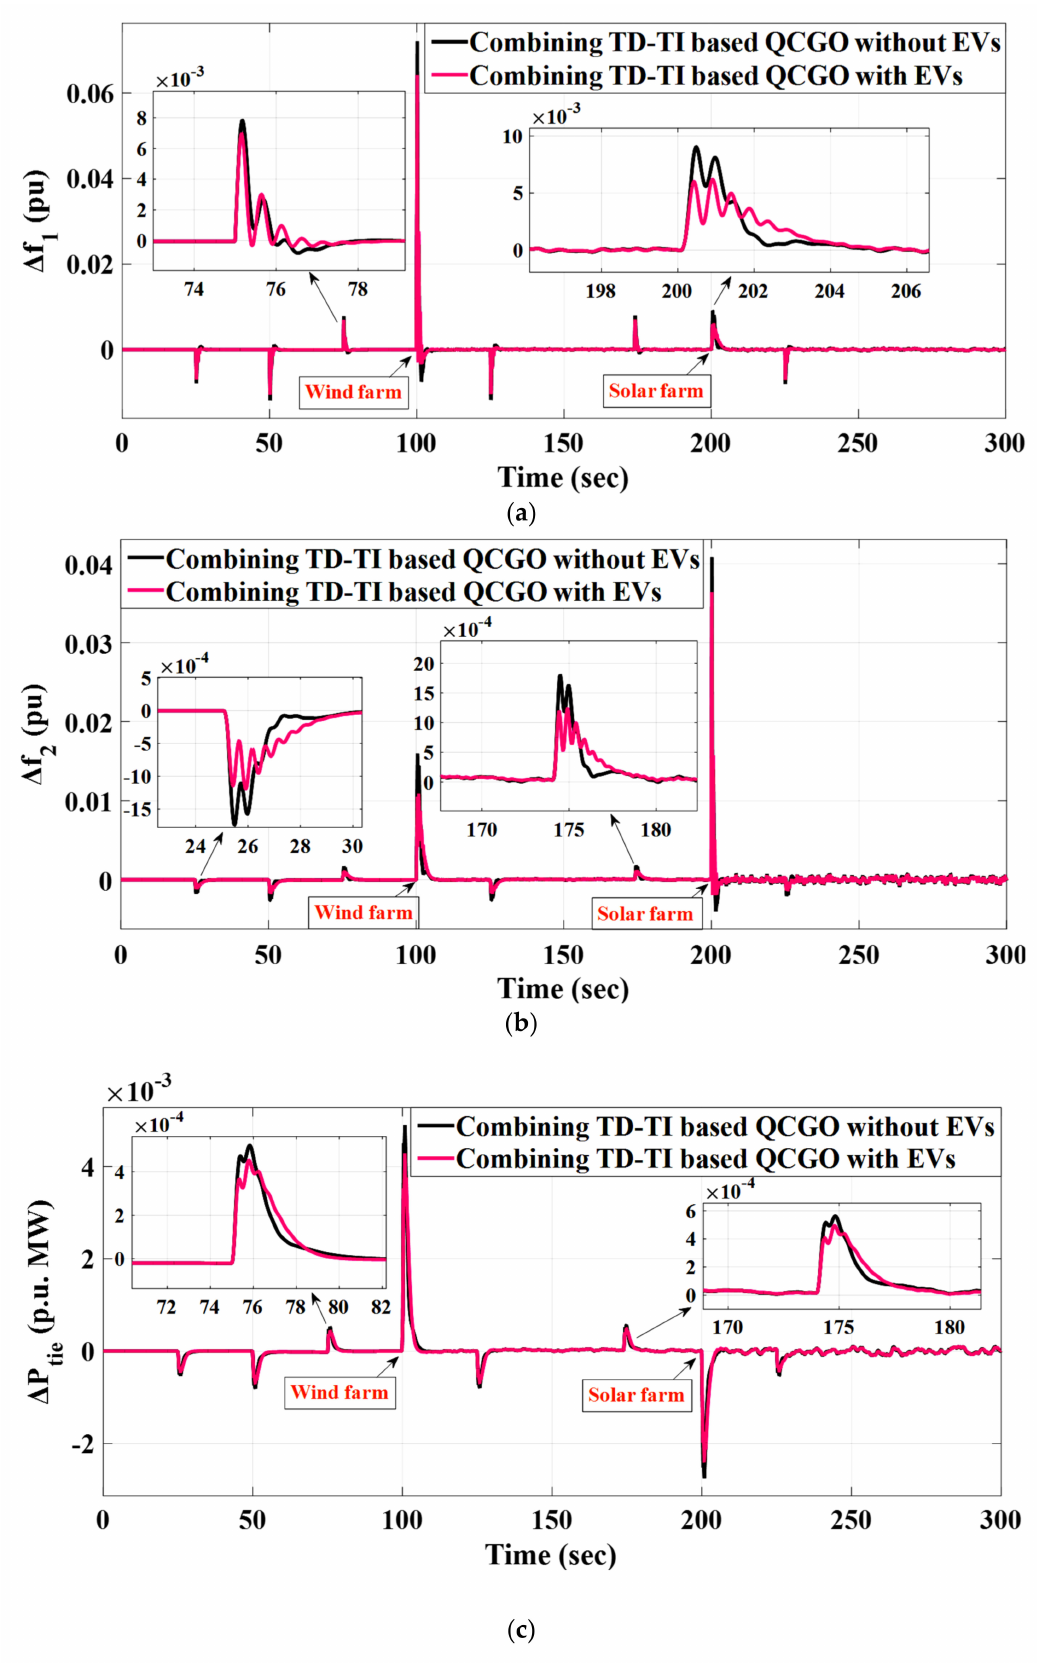
Figure 29. Dynamic power grid responses in case D: ( a ) ∆ f